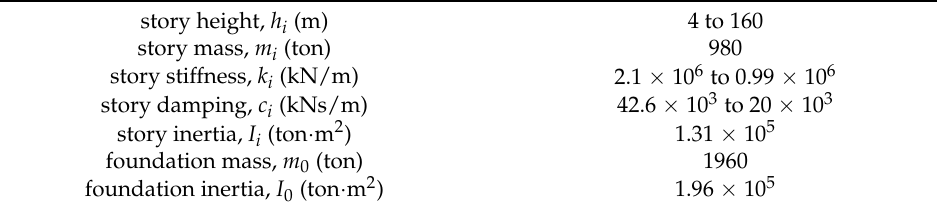
Table 4. Properties of the forty-story building.